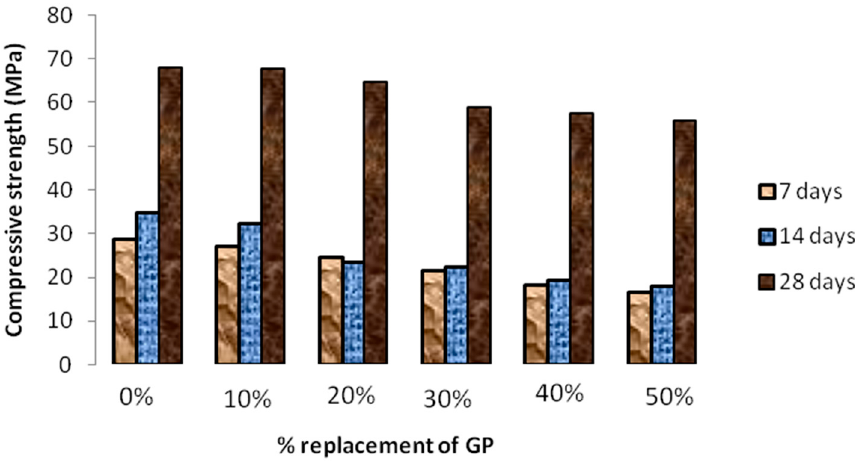
Figure 9. Compressive strength values of SCGM at various periods.